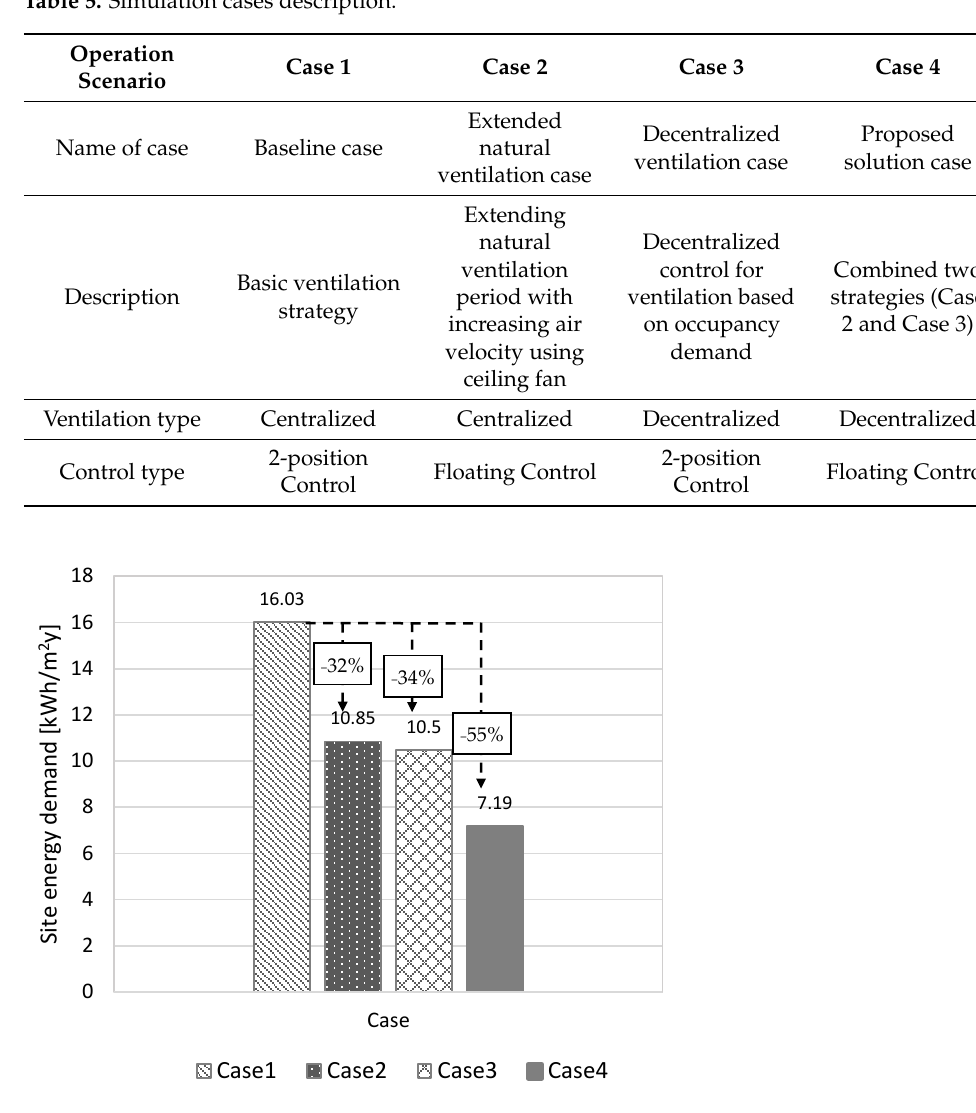
Figure 6. Site energy demand according to each strategy.